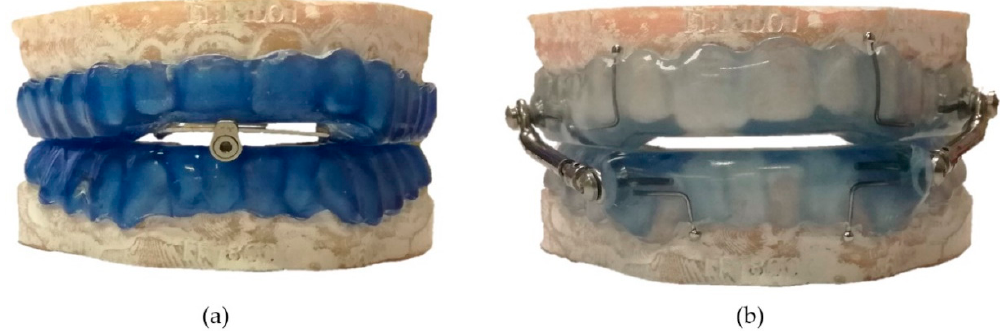
Figure 6. Mandibular advancement devices used in the present study: ( a ) MAD1 and ( b ) MAD2.